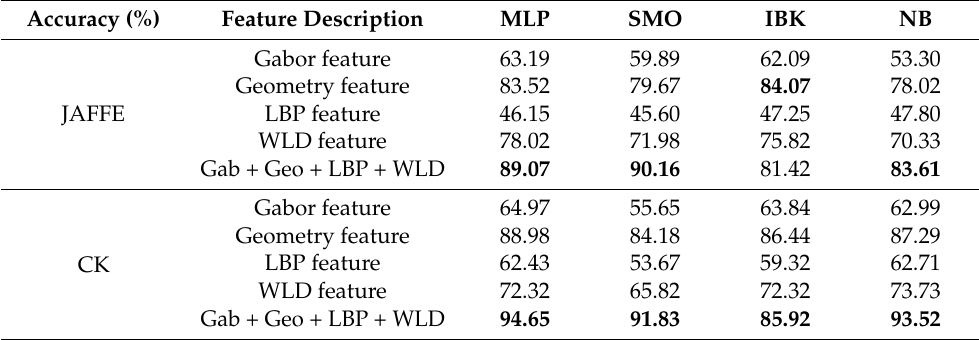
Table 7. Comparing recognition results with simple feature and multi-feature based on AU.